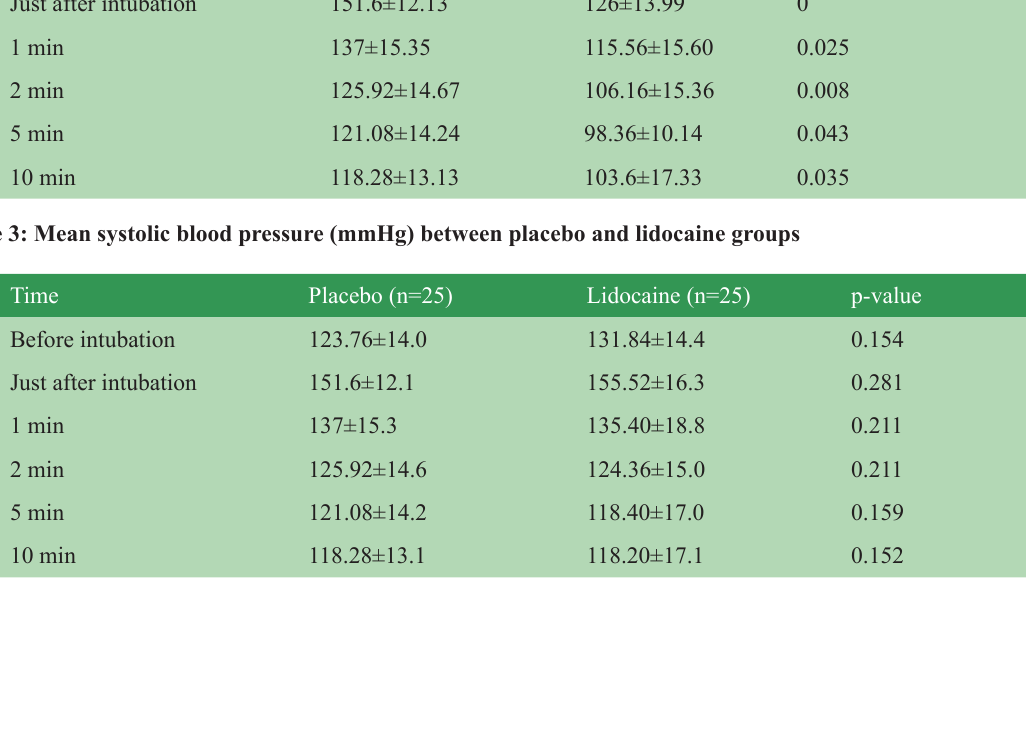
Table 2: Mean systolic blood pressure (mmHg) between placebo and esmolol groups Time Placebo (n=25) Esmolol (n=25) p-value Before intubation 123.76±14.07 Just after intubation